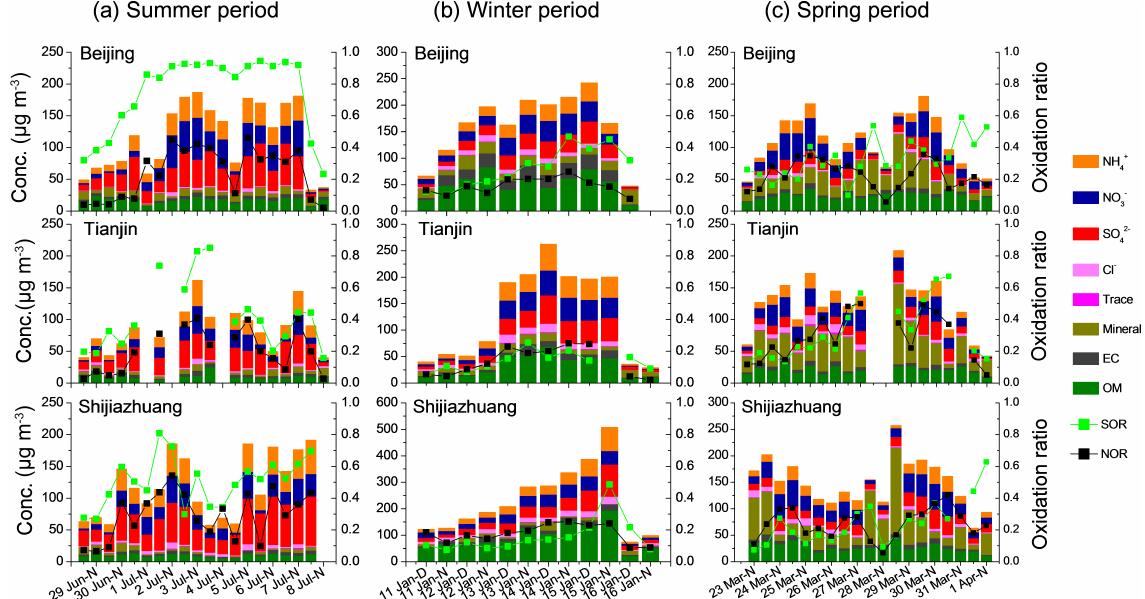
Figure 8. The evolution of the chemical species, sulfur oxidation rate (SOR), and nitrogen oxidation rate (NOR) in the specific pollution periods in summer (a) , winter (b) , and spring (c) at the urban sites. D: daytime; N: nighttime.